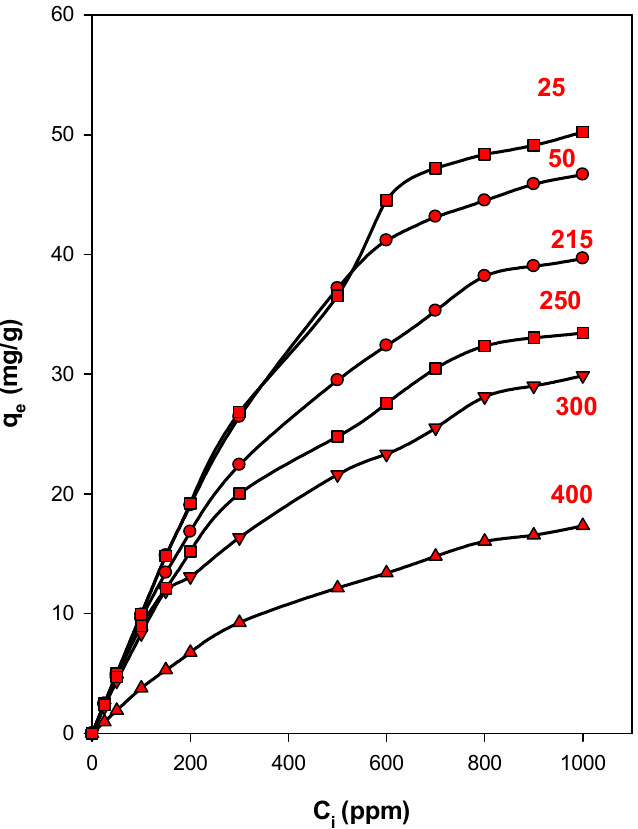
Figure 11. Eosin removal properties of C 16 Cl-CN organoclay preheated at different temperatures (°C).